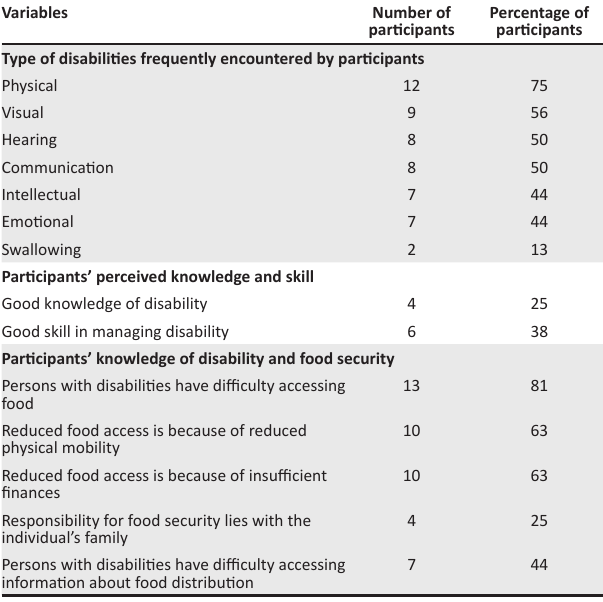
TABLE 1: Summary of participant responses.